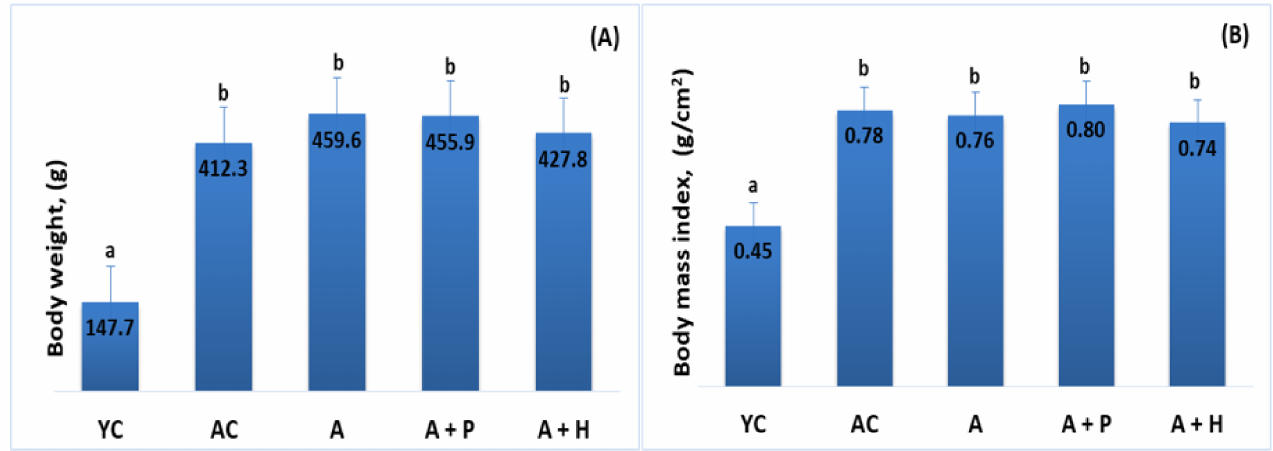
Figure 1. ( A ) Body weight and ( B ) body mass index of the animals from the experimental groups. The results are presented as mean values ± SEM. Different small letters indicate statistically significant differences ( p < 0.05): a and b = YC vs. AC; YC vs. A; YC vs. A + P; YC vs. A +